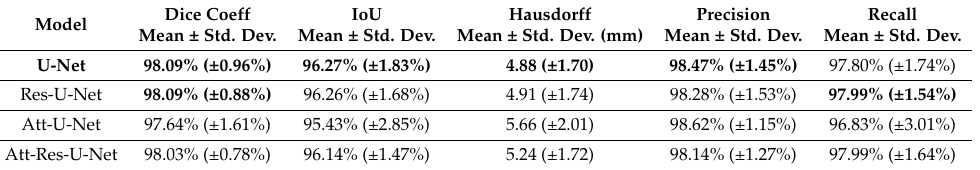
Table 2. Metric-based evaluation of different U-Net architectures. The best result is in bold. Dice Coeff Model Mean ± Std.